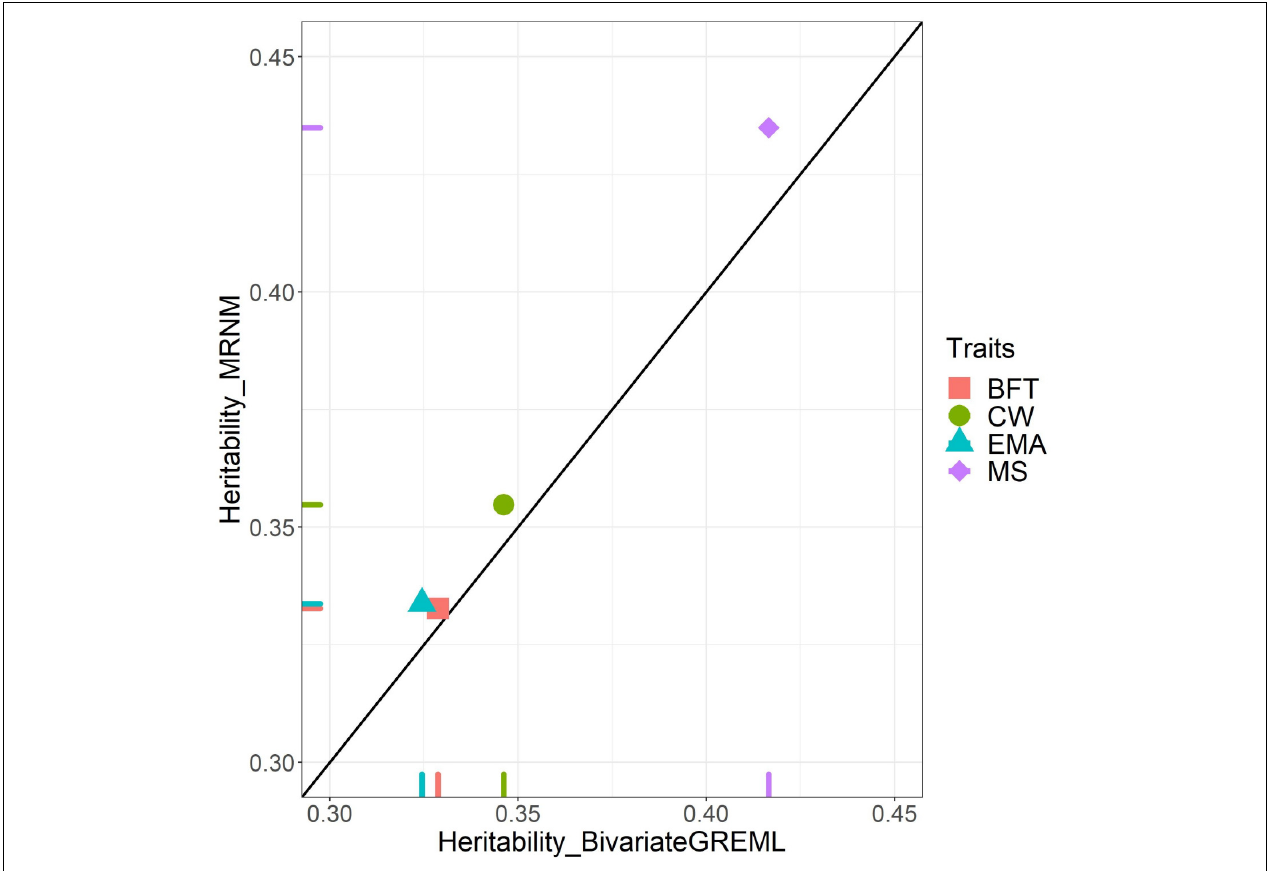
FIGURE 2 | Bivariate GREML versus MRNM heritability estimates. This figure indicates the heritability difference between bivariate GREML (MRNM without GxE interaction) and MRNM with combined G × E THI and R × E THI for four carcass traits; carcass weight (CW), back fat thickness (BFT), eye muscle area (EMA), and marbling score (MS). X -axis and Y -axis are the heritability estimated from bivariate GREML and combined G × E THI and R × E THI interaction model of MRNM, respectively. MRNM with no interaction (i.e., Null model) is used as bivariate GREML. If bivariate GREML and MRNM estimates are identical, they are placed on the diagonal line. For CW, EMA, and MS, we identified that the estimated residual variances from bivariate GREML and MRNM are significantly different ( p = 3.20E–02, 2.92E–02, and 3.37E–05 for CW, EMA, and MS based on theory (Ni et al., 2019; see Supplementary Note 1 ). It is noted that the estimated genetic variances are constant ( Supplementary Figure 3 ), confirming that estimated genetic variance is invariant whether using an additive model or a non-additive interaction model (Ni et al., 2019). Therefore, the heritability differences for CW, EMA and MS were mostly due to the difference of residual variance between two